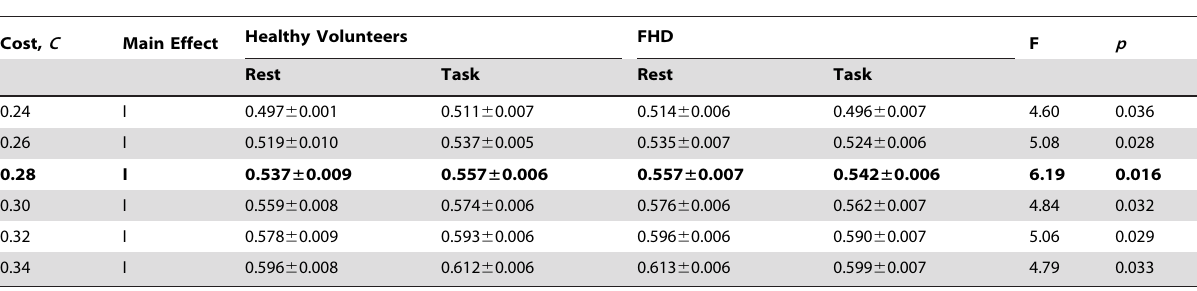
Table 2. Eglob showing significant differences.